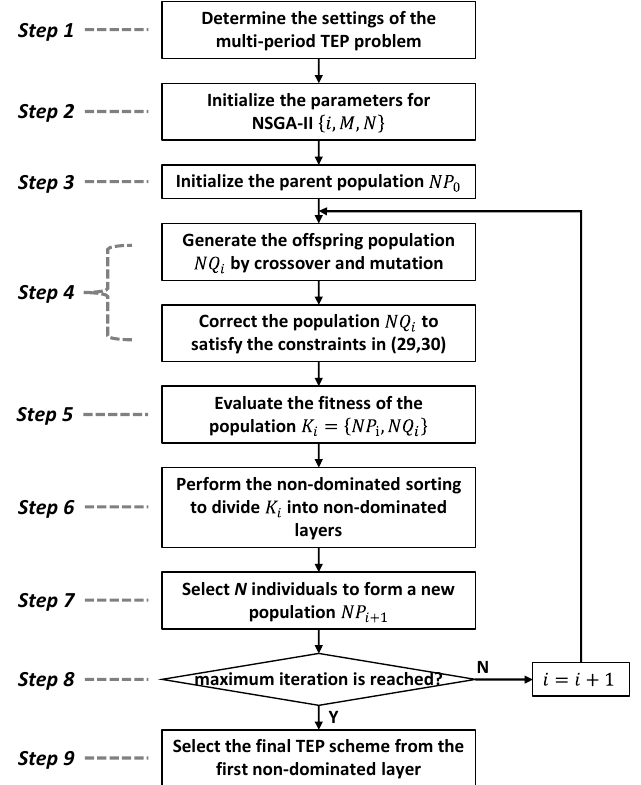
Figure 2. Flowchart of the procedure of computation of the TEP scheme based on NSGA-II.